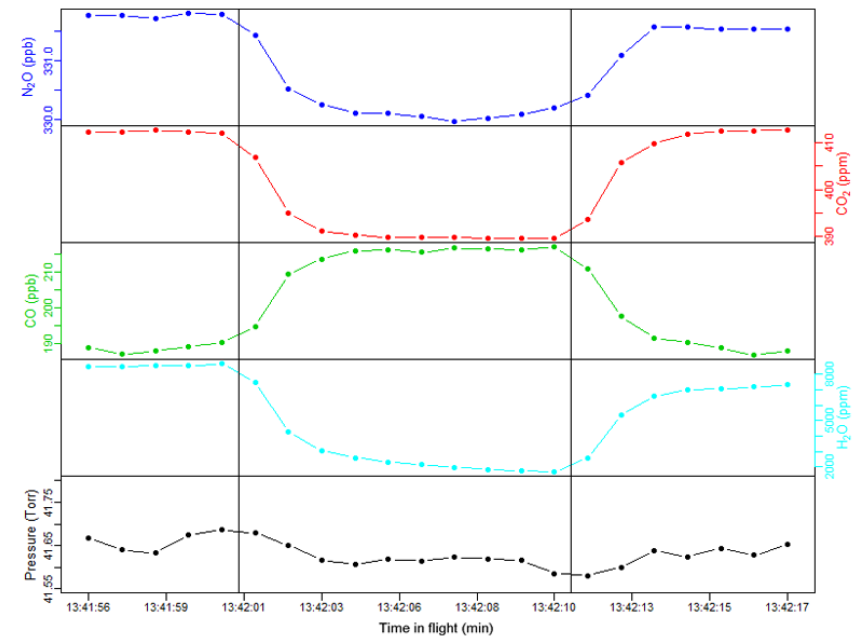
Figure 5. Example of in-flight calibration, showing time series of N 2 O, CO 2 , CO, H 2 O, and cell pressure. Vertical lines indicate when the solenoid valve was actuated or closed. The first 5s of each calibration is treated as equilibration time, and the last 5s is used to find a mean calibration